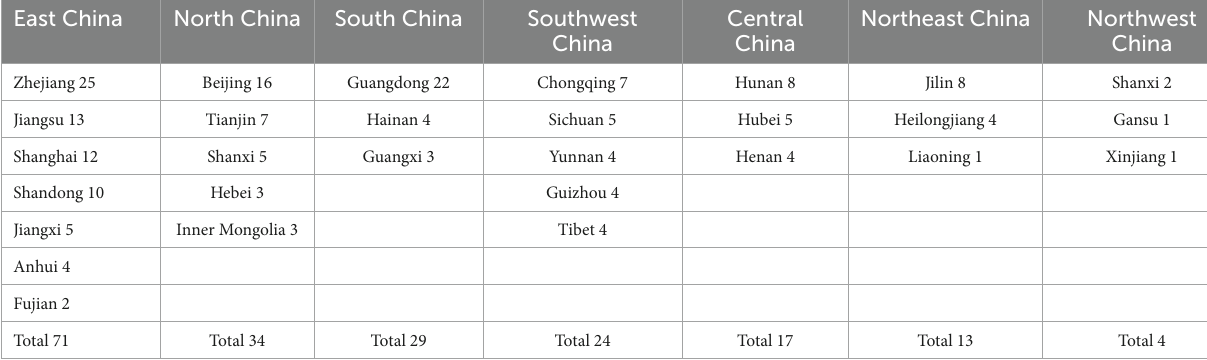
TABLE 2 Number of listed companies in the health industry by